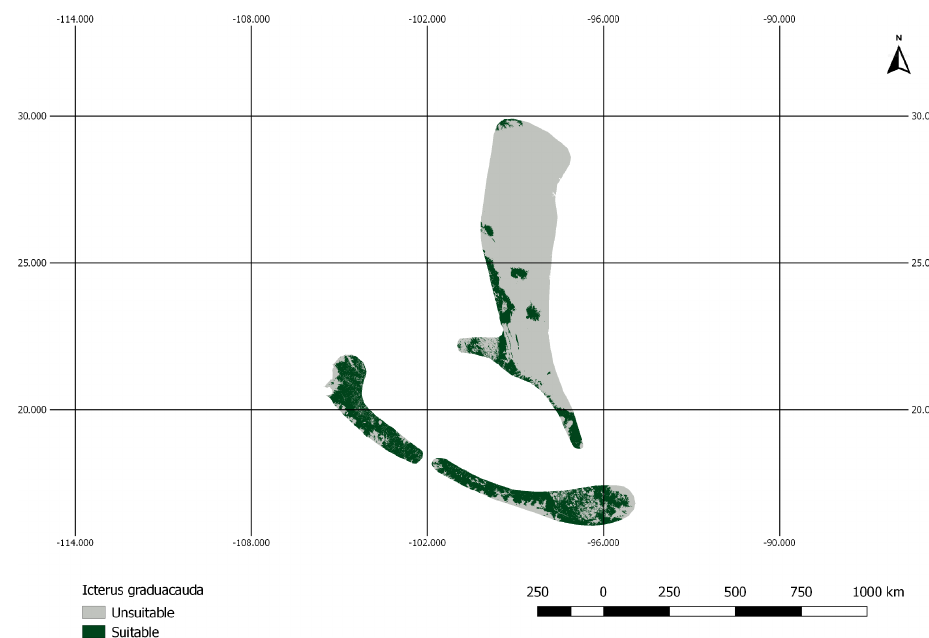
Figure A2. AOH map for the species Icterus graduacauda . The IUCN range of the species does not cover much of the elevation range. Therefore, the model prevalence of this species is lower than